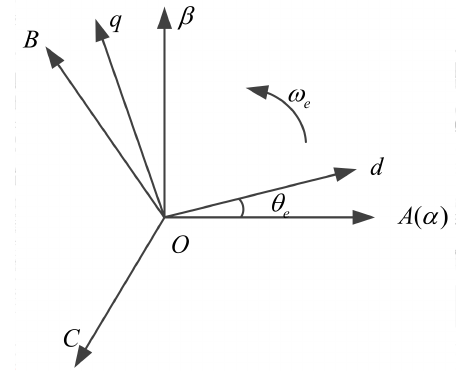
Figure 1. Relationship between the various coordinate